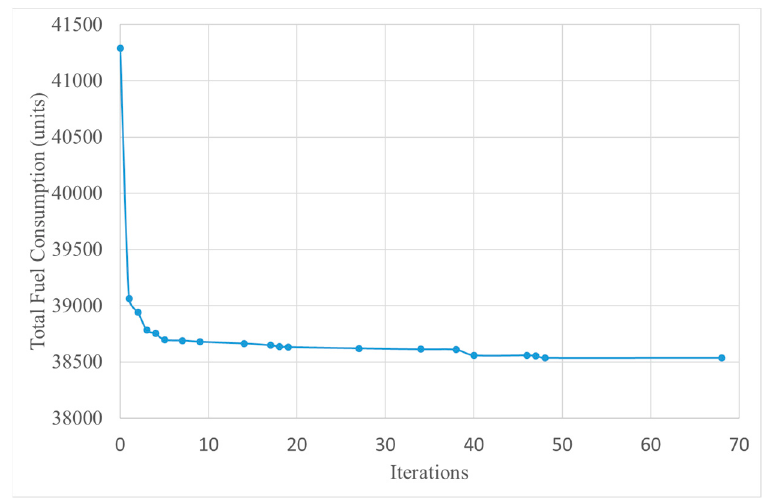
Figure 2. Total fuel consumption changes in each iteration for the example problem.